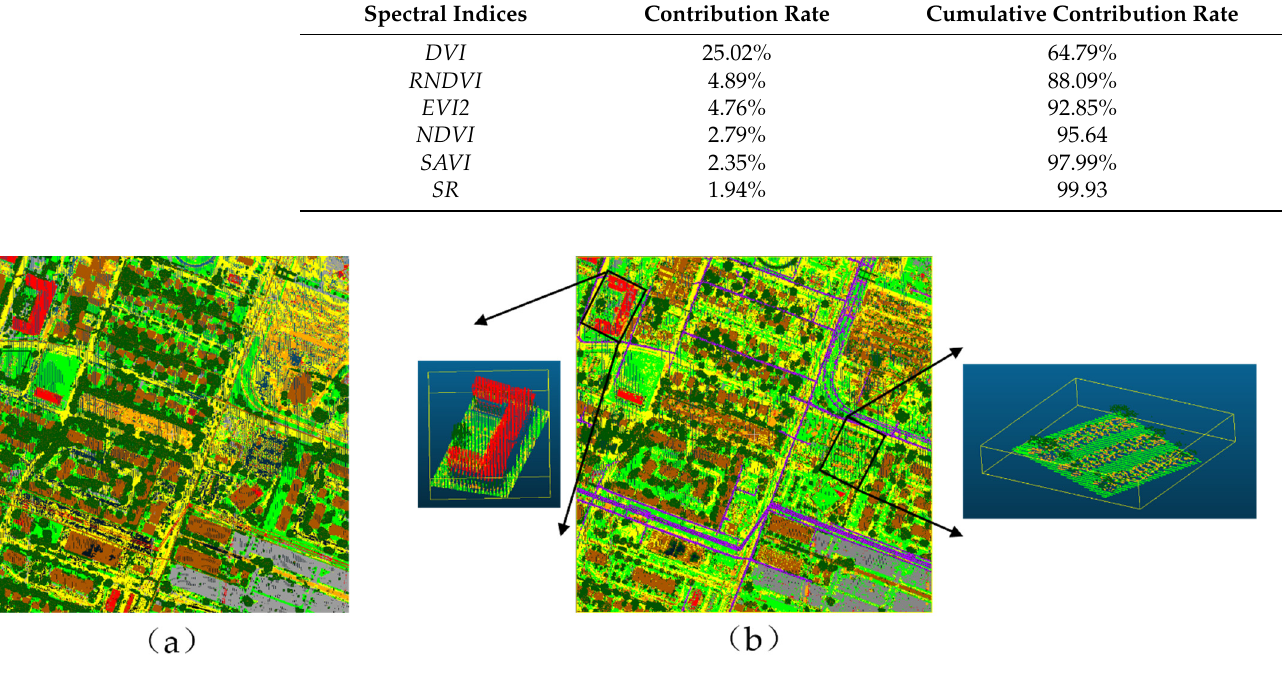
Figure 9. ( a ) Classification results based on the intensity of the 1064 nm and 532 nm channels; ( b ) classification results based on all six spectral indices and the intensity of the 1064 nm and 532 nm channels .